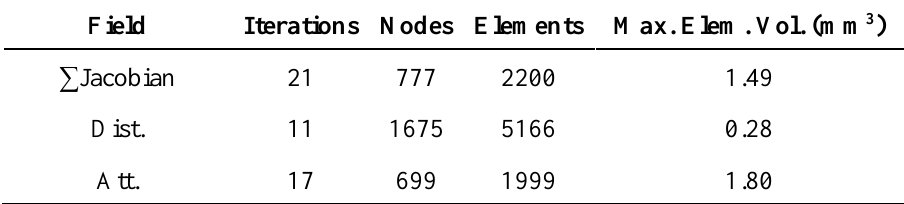
Figure 7. Mesh at convergence for ( a ) 𝐷𝑖𝑠𝑡. and ( b ) 𝐴𝑡𝑡. Table 4. Mesh characteristics at convergence under different solution